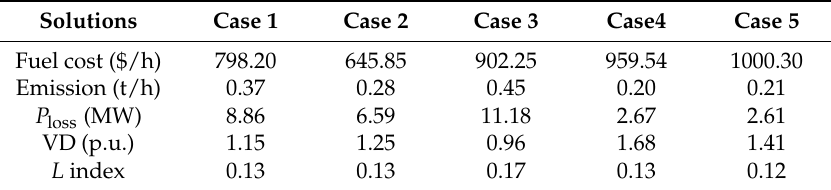
Table 4. Optimal solution of IEEE 30 bus power system for case studies 1 to 5.